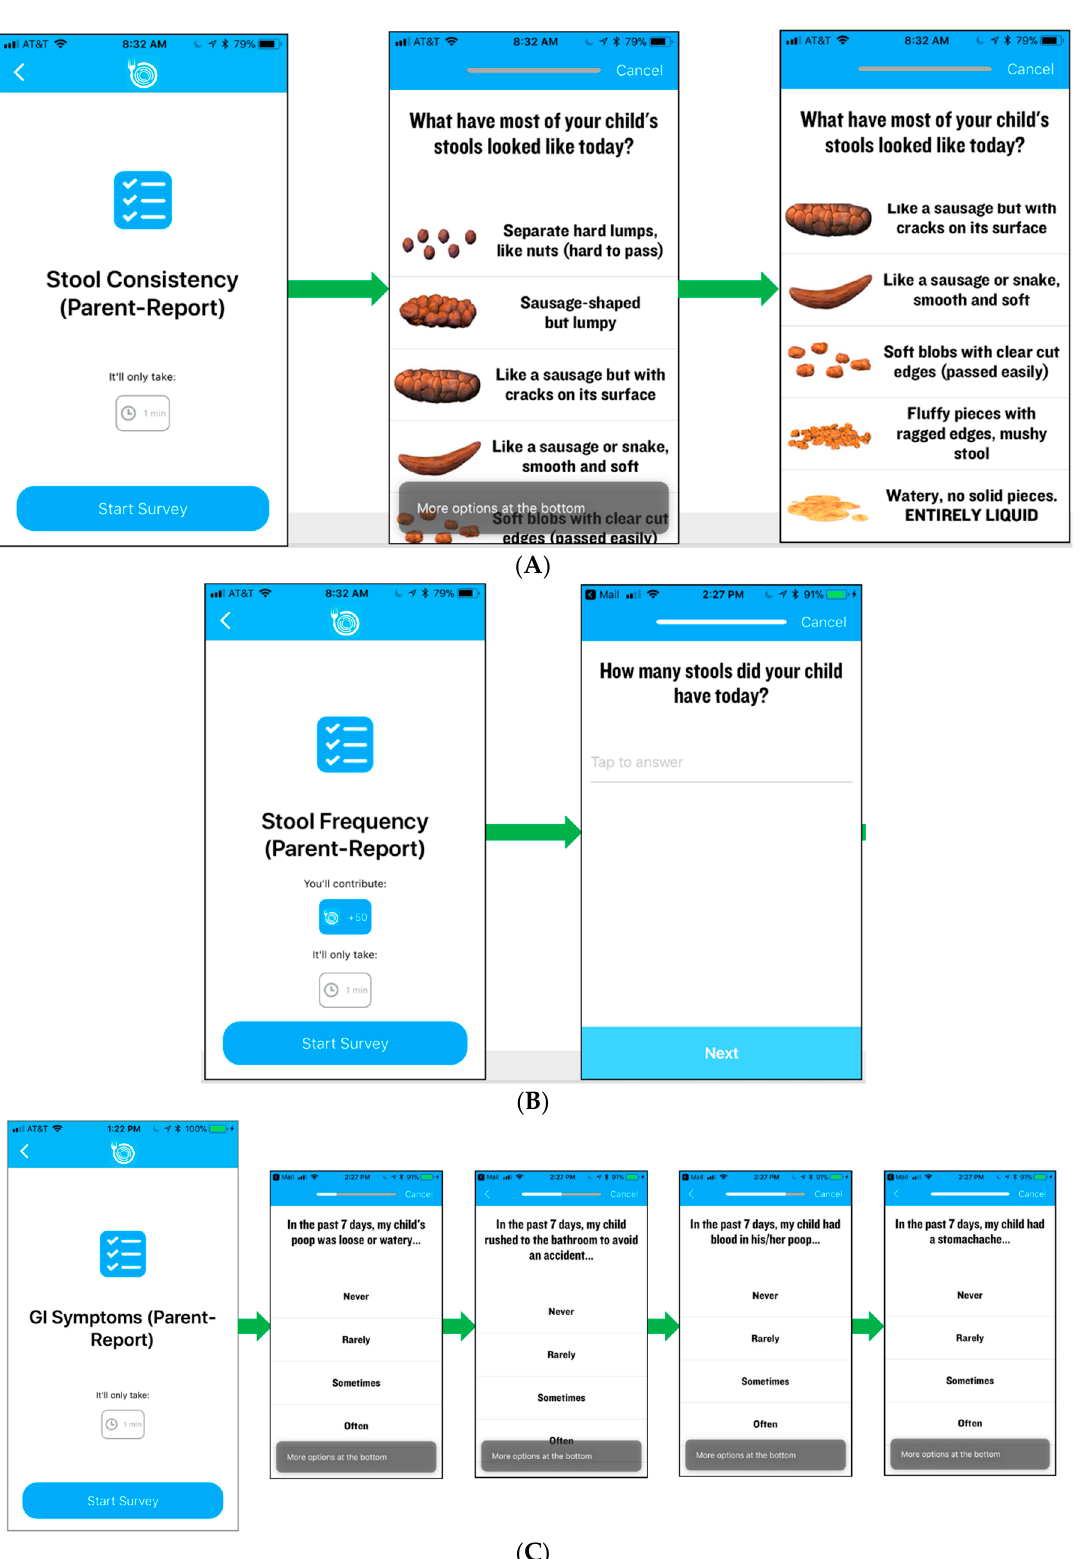
Figure 3. Screen shots of the participant facing mobile application data entry screens for ( A ) stool consistency, ( B ) stool frequency, and ( C ) Gastrointestinal (GI) symptoms.